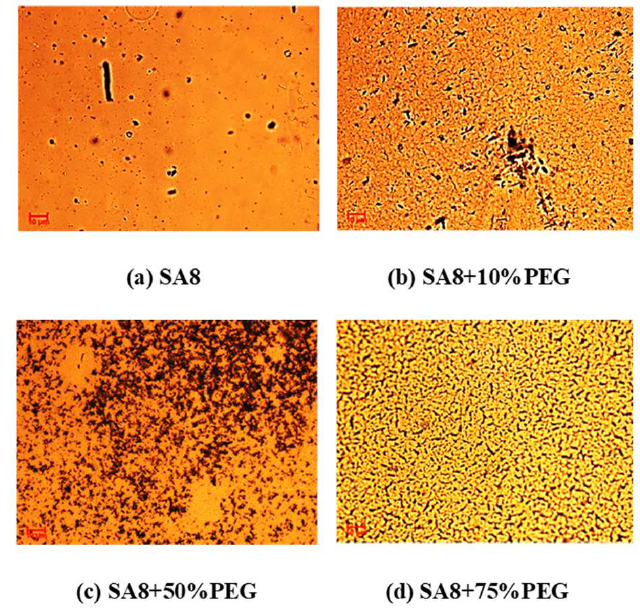
Figure 19. The morphology diagram of SA8 blended with PEG.